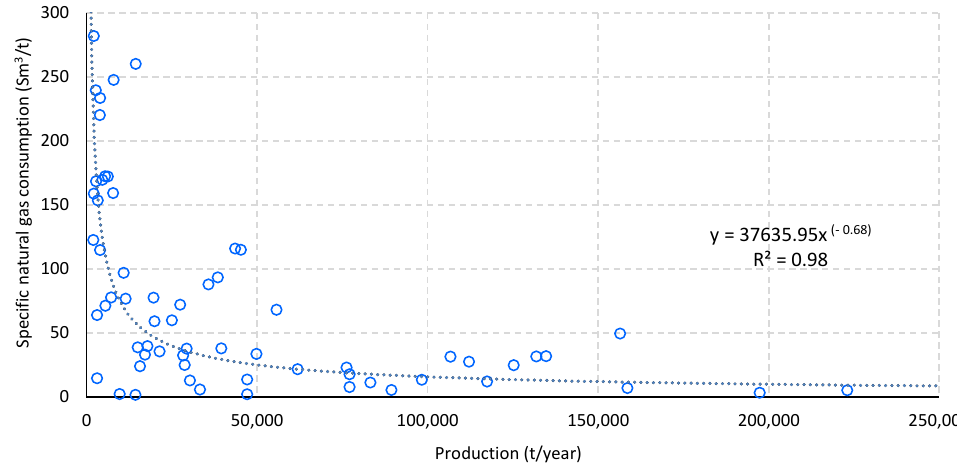
Figure 5. Trend of specific natural gas consumption as a function of the annual production capacity of dairy enterprises.